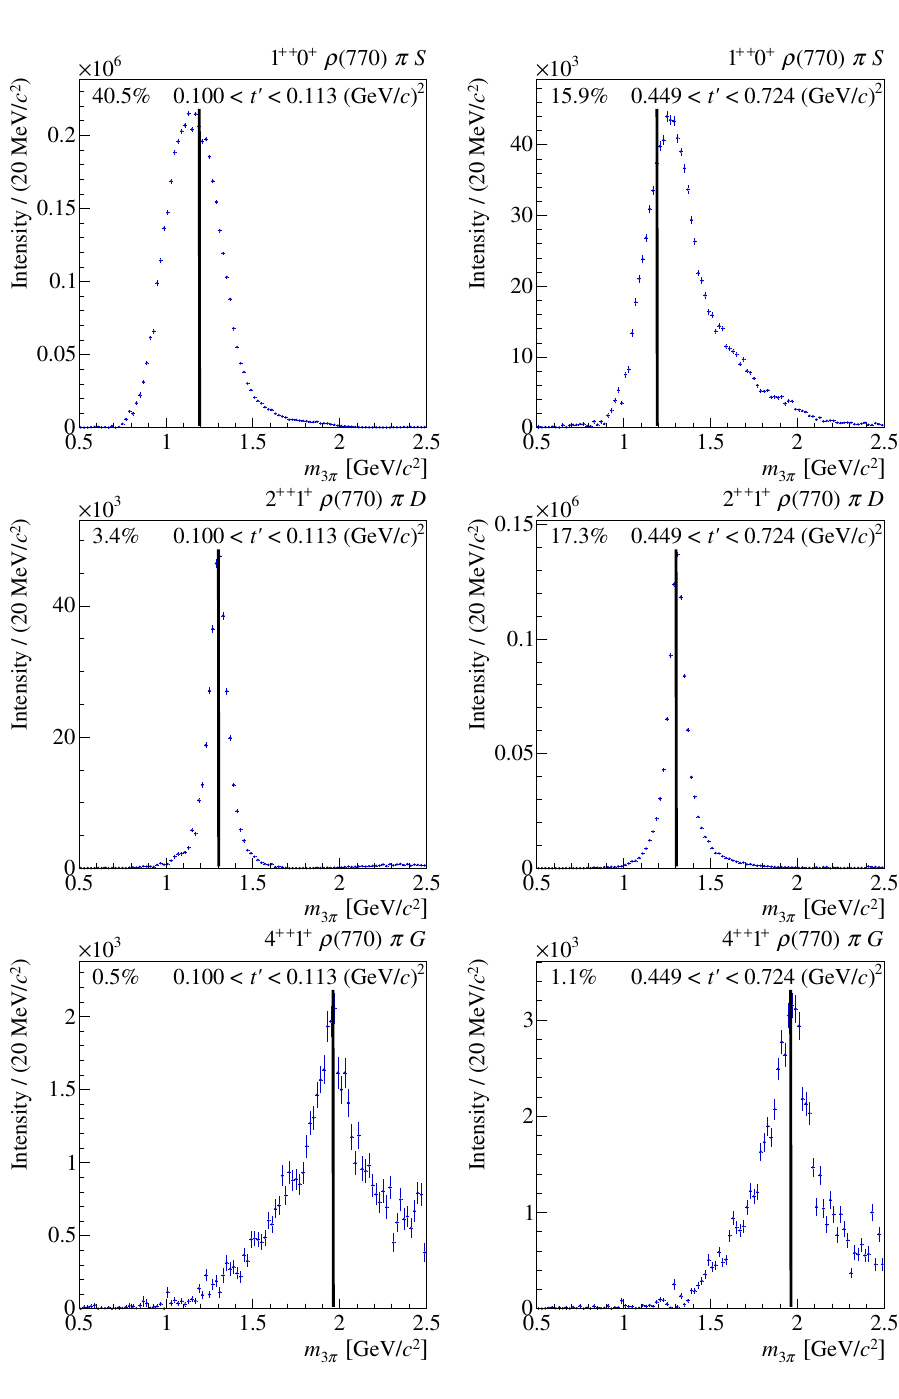
Figure 4. Results for the PWA of 3 charged pions produced in di ff ractive dissociation at COMPASS. The left column is for the lowest bin in momentum transfer t (cid:9) , the right column for the highest t (cid:9) bin. Percentages in the left-upper corner of the graphs indicate the fraction with respect to the total intensity. Further discussion see